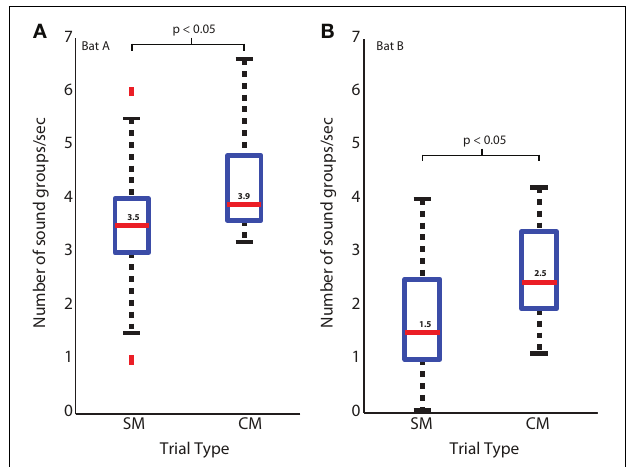
FIGURE 5 | Sound groups during simple and complex target motions. (A) Bat A sound group usage for simple and complex target motion trials. Blue box represents the middle 50% of the data, red bar is the median. Black bars detail the range of the data, and red dots are outliers. (B) Same as in (A) , but for Bat